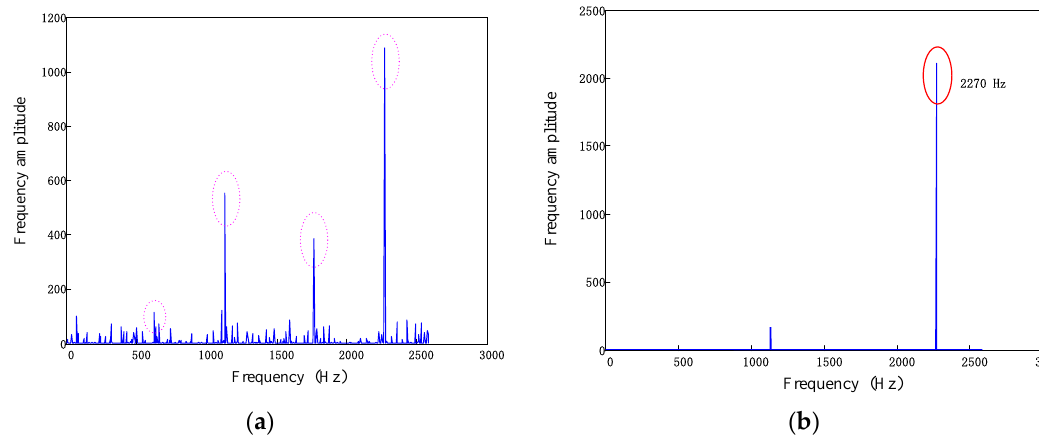
Figure 17. The recovered spectrum of sample streams based on ( a ) BP algorithm ( b ) BPDN